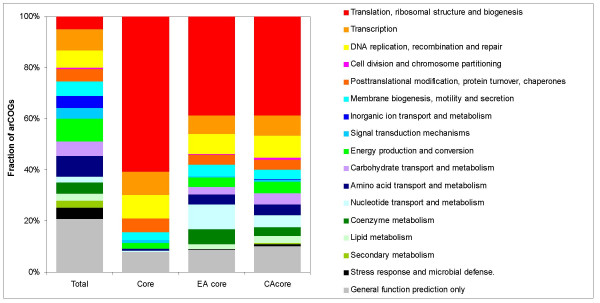
Functional breakdown of the entire set of arCOGs and the three core sets. EA, Euryarchaea, CA, Crenarchaea.